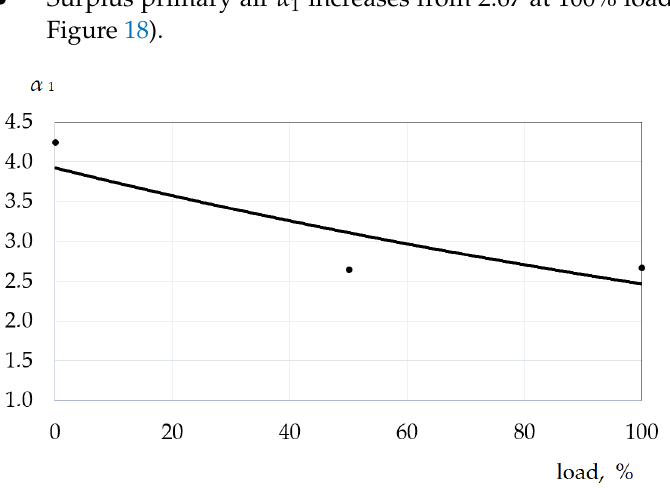
Figure 18. Dependence of surplus primary air on the load value.